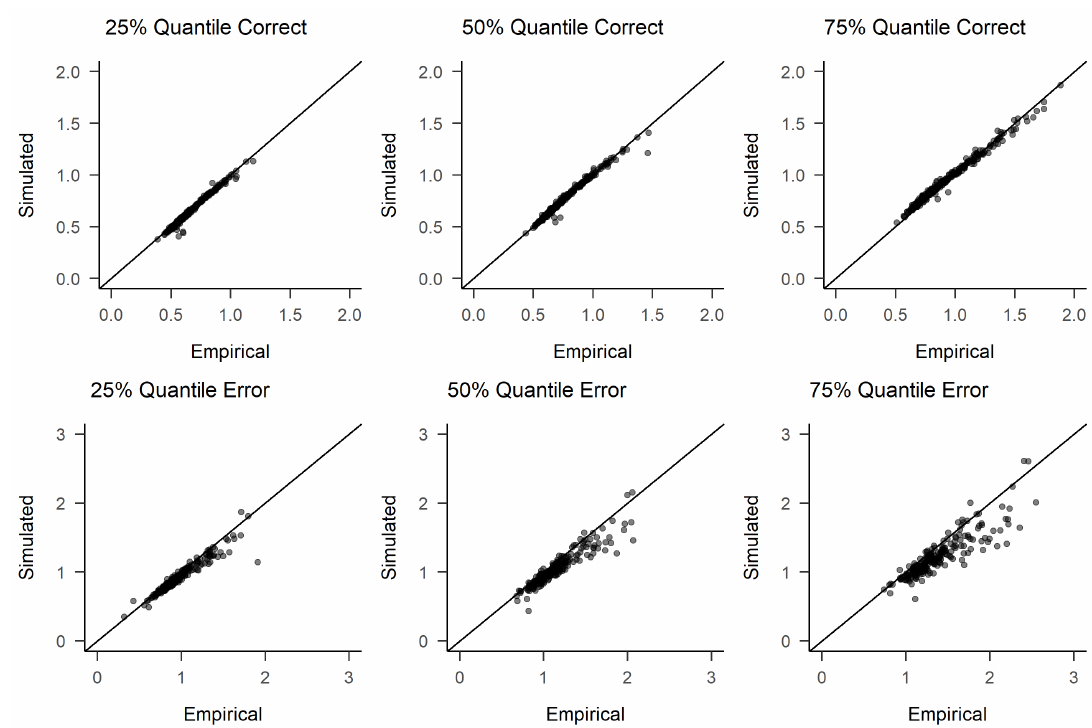
Figure A3. Posterior predictive check of RTs for T4. Participants with 10 or less errors are omitted from the error response time plots.